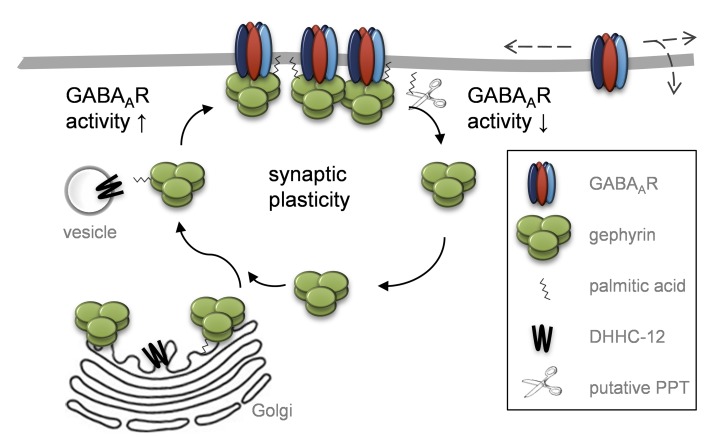
Model for palmitoylation-mediated regulation of gephyrin clustering and plasticity.Gephyrin, palmitoylated on Cys212 and 284, forms stable clusters at the postsynaptic membrane. Activity of GABAergic synapses promotes (de)palmitoylation of gephyrin by yet unknown mechanisms. Silencing of GABAergic transmission leads to gephyrin depalmitoylation and membrane release, ultimately decreasing the size of gephyrin clusters. The palmitoyl transferase DHHC-12, localized in the Golgi in neurons including presumed Golgi outposts in primary dendritic shafts, is the principle gephyrin-palmitoylating enzyme and allows dynamic (re)palmitoylation of gephyrin.